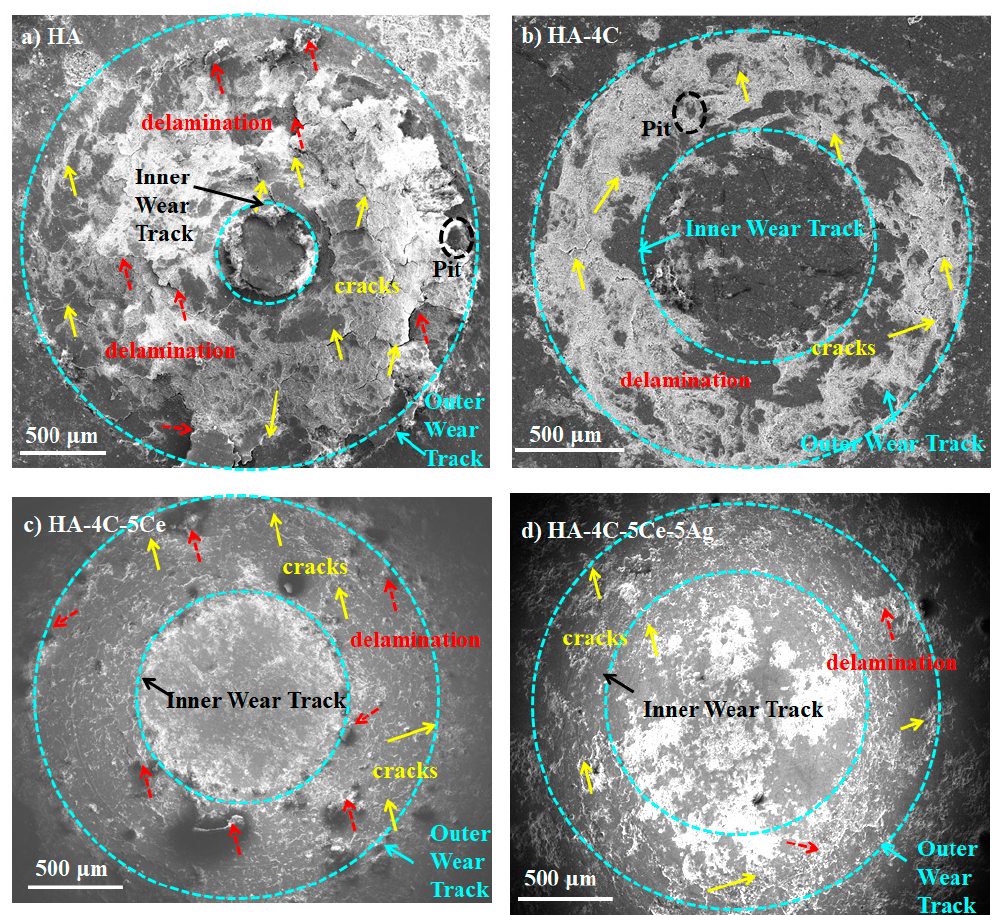
Figure 6. Micrographs showing the worn surface scar of ( a ) HA, ( b ) HA-4C, ( c ) HA-4C-5Ce, and ( d ) HA-4C-5Ce-5Ag (yellow and red arrows show cracks and delamination, respectively). Wear rate ( W R ) was calculated using the following Equation (5) and shown in Table 2. (cid:1849) (cid:3049) (cid:1849) (cid:3019) = where S is the sliding distance. The wear rate was estimated to be highest for HA, 176.1 × 10 − 6 mm 3 ·N − 1 ·m − 1 , which was reduced by 3 times to 54.7 × 10 − 6 mm 3 ·N − 1 ·m − 1 for HA-4C, with a further Table 1. The achieved wear rate in the coatings can also be correlated with the tribofilm formation (and thickness) with CNT, CeO 2 , and Ag reinforcement as seen by the SEM images in Figures 5b–d. The relation of the bulk hardness ( H ) of the material with the wear volume can be studied using the Archard equation (to evaluate the wear constant, k ) via Equation (6). load, the resistance in wear loss by the hardness of the material portrays the wear constant. The wear constant of 13.8 × 10 − 3 was estimated for pure HA coating, illustrating highest wear loss. For HA-4C, the wear constant was found to be decreased to 6.7 × 10 − 3 . The extremely low values of wear constant, of 1.3 × 10 − 3 and 1.2 × 10 − 5 , was computed for HA-4C-5Ce and HA-4C-5Ce-5Ag, respectively, owing